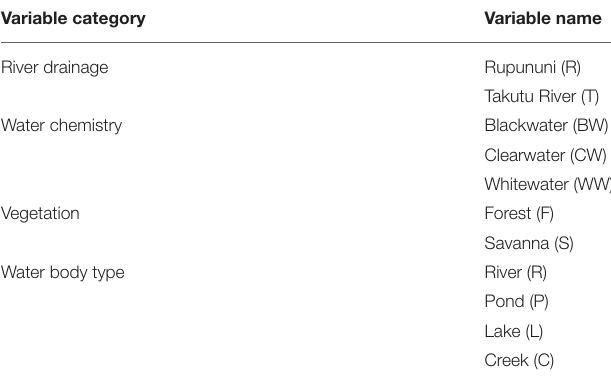
TABLE 1 | Description of categorical physical variables used in the analyses. Variable